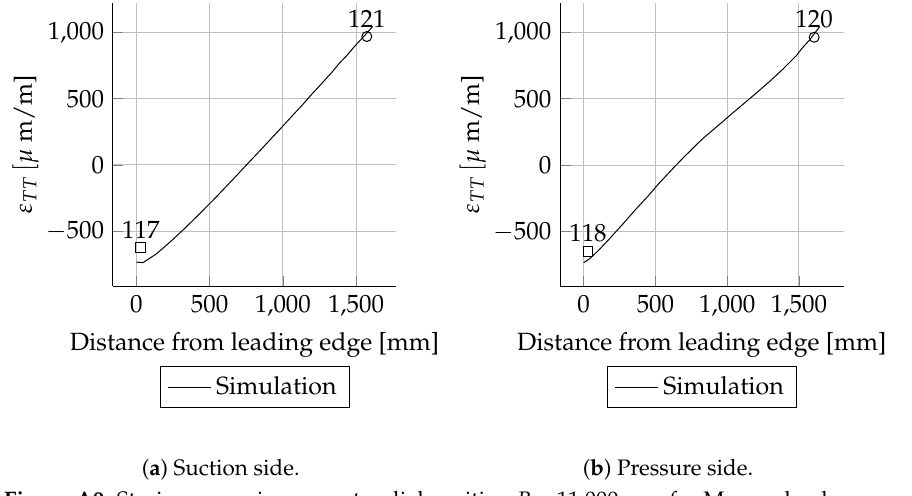
Figure A9. Strain comparison ε LL at radial position R = 11,000 mm for Mxmax load case.